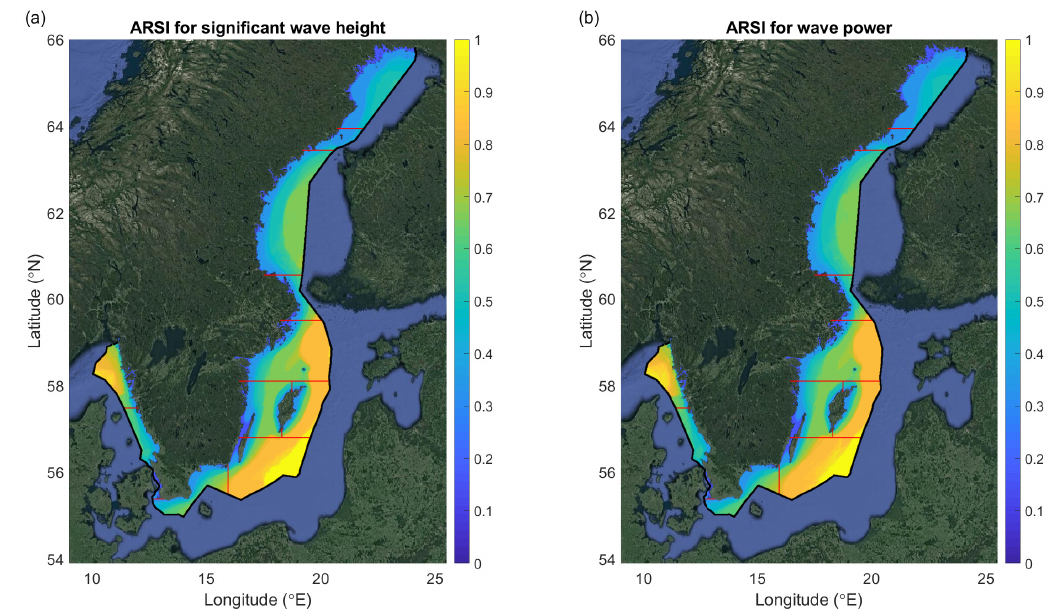
Figure 9. The ARSI for ice-free significant wave height (in ( a )) and for ice-free wave power resource (in ( b )) formulated based on the percentile limits in Figure 5. A value of one indicates that the area has been classified to have the 5% highest waves and wave power in all categories considered, and low values indicate the areas that have the lowest wave heights and wave power values for many of the categories considered. Sub-basin borders following Figure 1 are marked with red